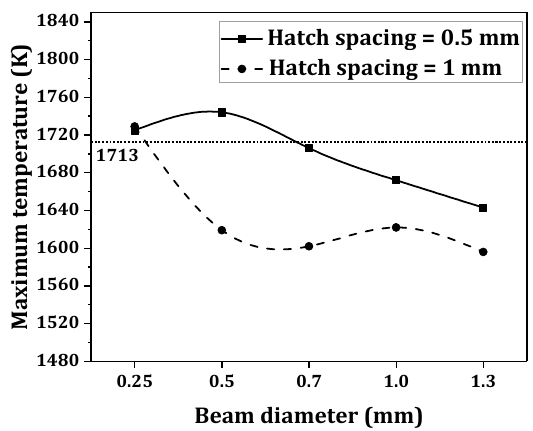
Figure 7. Maximum temperatures of the laser-formed samples from the finite element analysis.